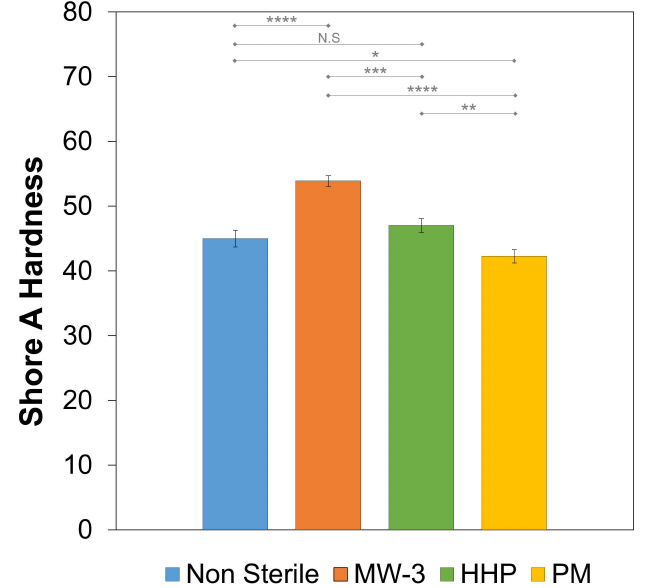
Figure 8. Shore A hardness values for the non-sterile and sterile PVA/PBO hydrogels. The error bars are the ± standard deviation ( n = 3). Statistical analysis was performed using Student- t test, with significance set at * p < 0.05, ** p < 0.01, *** p < 0.005, **** p < 0.001. N.S. = not